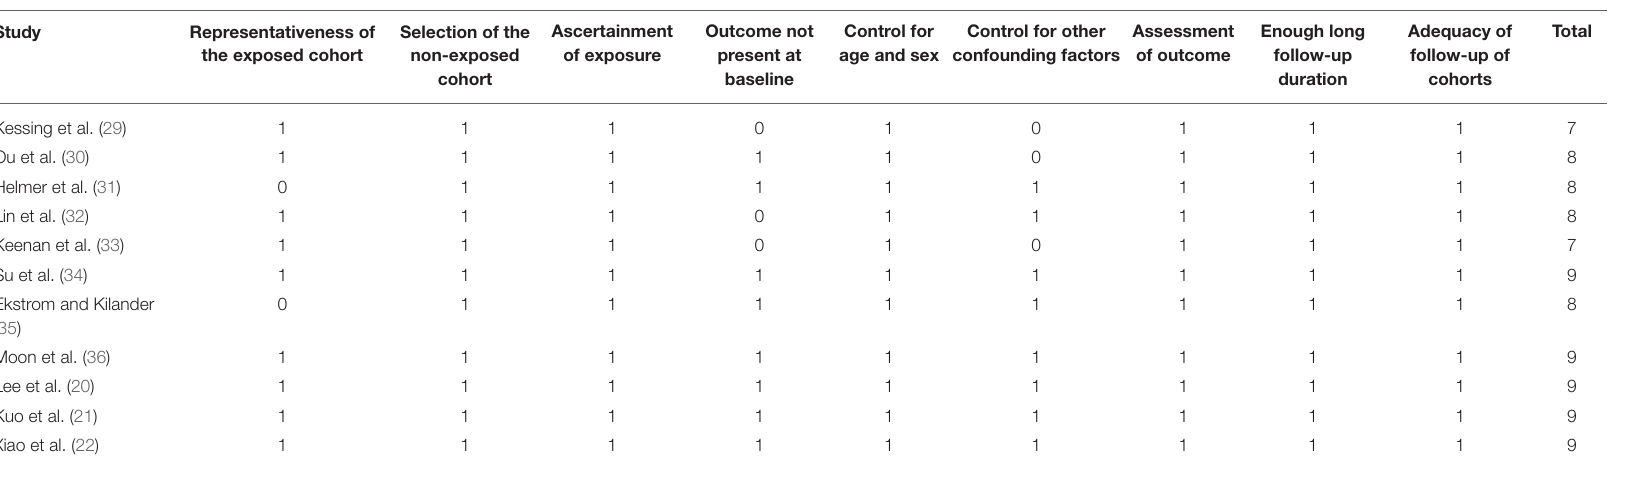
TABLE 2 | Details of quality evaluation via the newcastle-ottawa